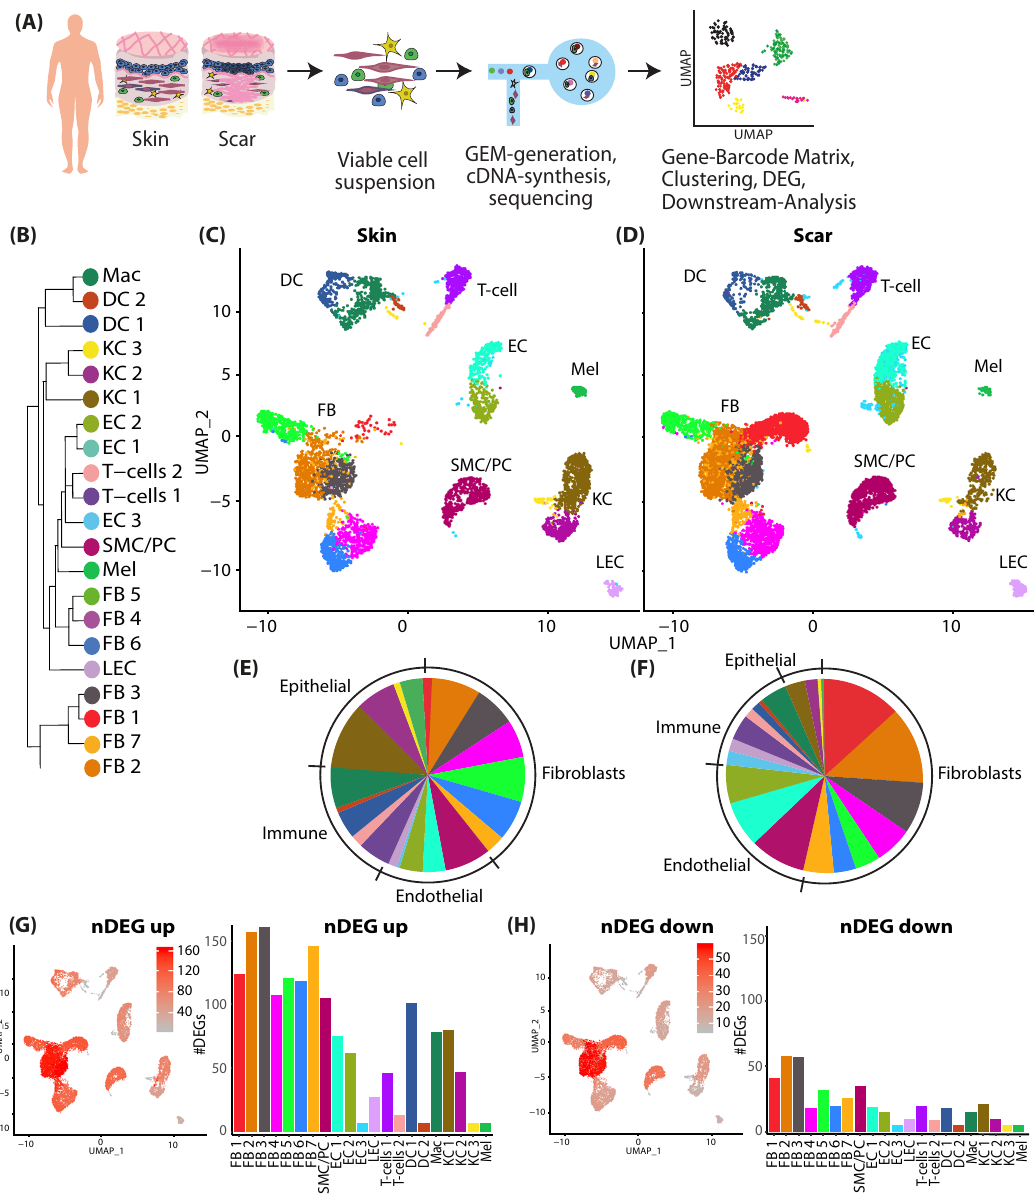
Fig. 1 Characterization of human skin and scar samples with scRNAseq identi fi es speci fi c cell clusters and a distinct fi brotic gene signature. A Work fl ow of scRNAseq in human skin ( n = 3) and scar ( n = 3) samples. B Phylogenetic clustertree calculated based on UMAP-clustering. C , D UMAP- plots of human skin and scar samples, split by tissue, after integration of all samples, identifying seven fi broblast clusters (FB1-7), smooth muscle cells and pericytes (SMC/Peri), endothelial cells (EC1 + 2), lymphatic endothelial cells (LEC), T cells, macrophages (Mac), dendritic cells (DC1 + 2), three keratinocyte clusters (KC1-3), and melanocytes (Mel). E , F Pie charts showing ratios of cell clusters in skin and scars. Feature plots and bar graphs of number of differentially expressed genes (nDEG) per cluster of G up- and H downregulated genes. DEGs were calculated per cluster comparing scar versus skin using Wilcoxon rank-sum test, including genes with average logarithmic fold change (avglogFC) of >0.1 or < − 0.1 and Bonferroni-adjusted p -value <0.05. Feature plots show projection of nDEG onto the UMAP-plot, color intensity represents nDEG. Bar graphs show absolute numbers of nDEG per cluster, y -axis represents nDEG. UMAP, uniform manifold approximation and